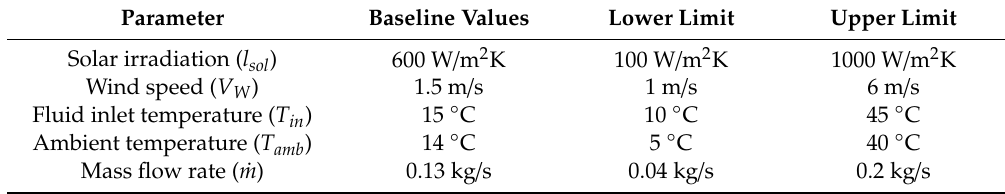
Table 3. Baseline, maximum, and minimum values for the performed parameters.